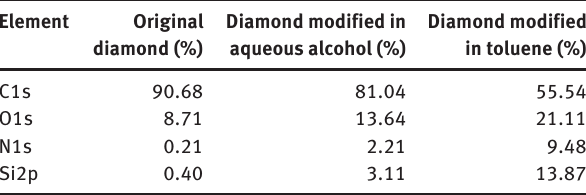
Table 1: The element content analysis of diamond surface obtained by using XPS analysis.